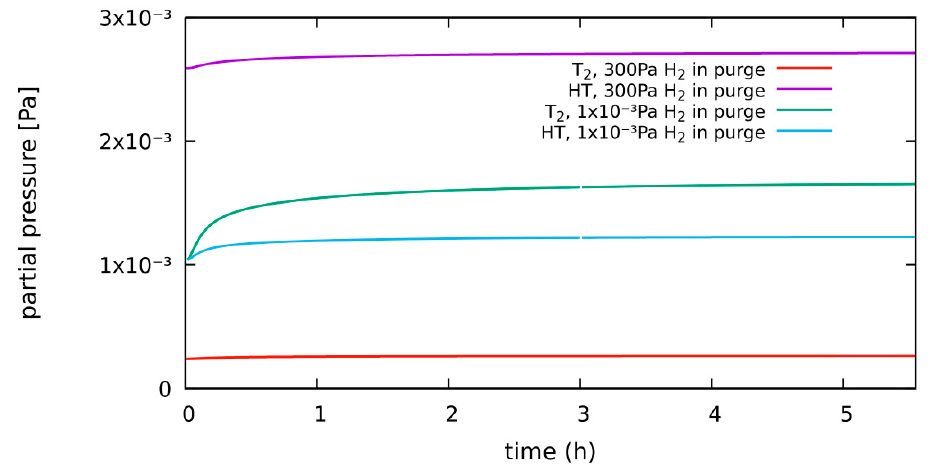
Figure 7. Transient T 2 and HT partial pressure at coolant outlet for 1 × 10 − 3 Pa vs. 300 Pa H 2 in the purge gas.